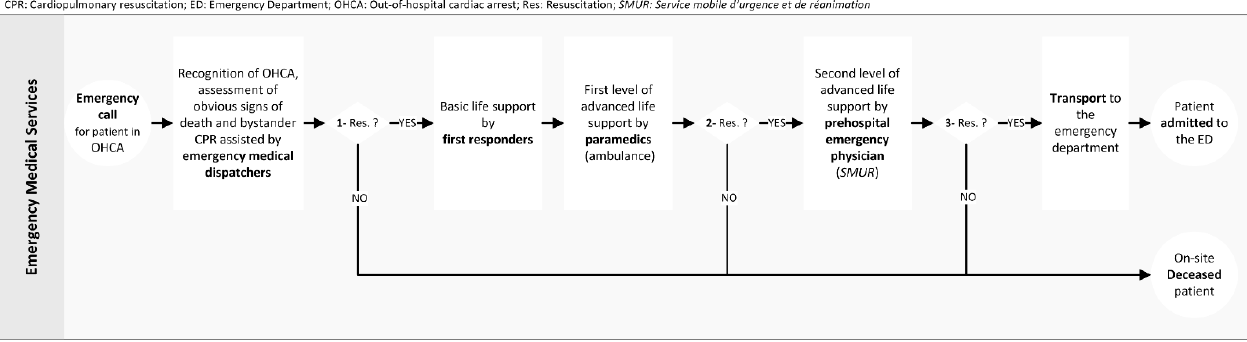
Figure 1. Geneva process for the management of out-of-hospital cardiac arrest and decision points.